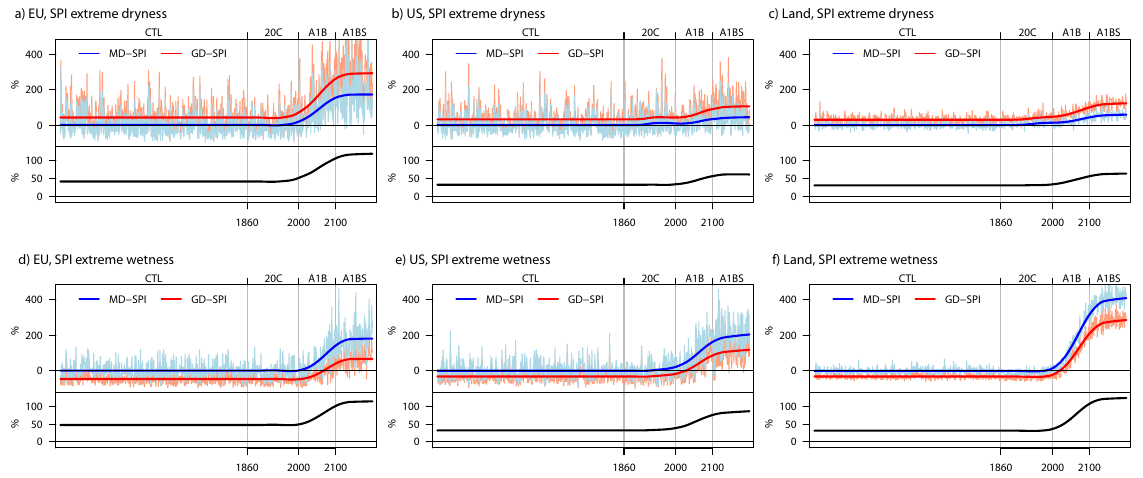
Fig. 15. Time series of SPI dry (a–c) and wet (d–f) extreme occurrences in each year for the European region (EU, left), the contiguous United States (US, middle) and global land areas (right). Shown are the differences in percent to the expected probability (2.3%) for MD-SPI and GD-SPI separately (upper panels) and the magnitude of the differences between them (lower